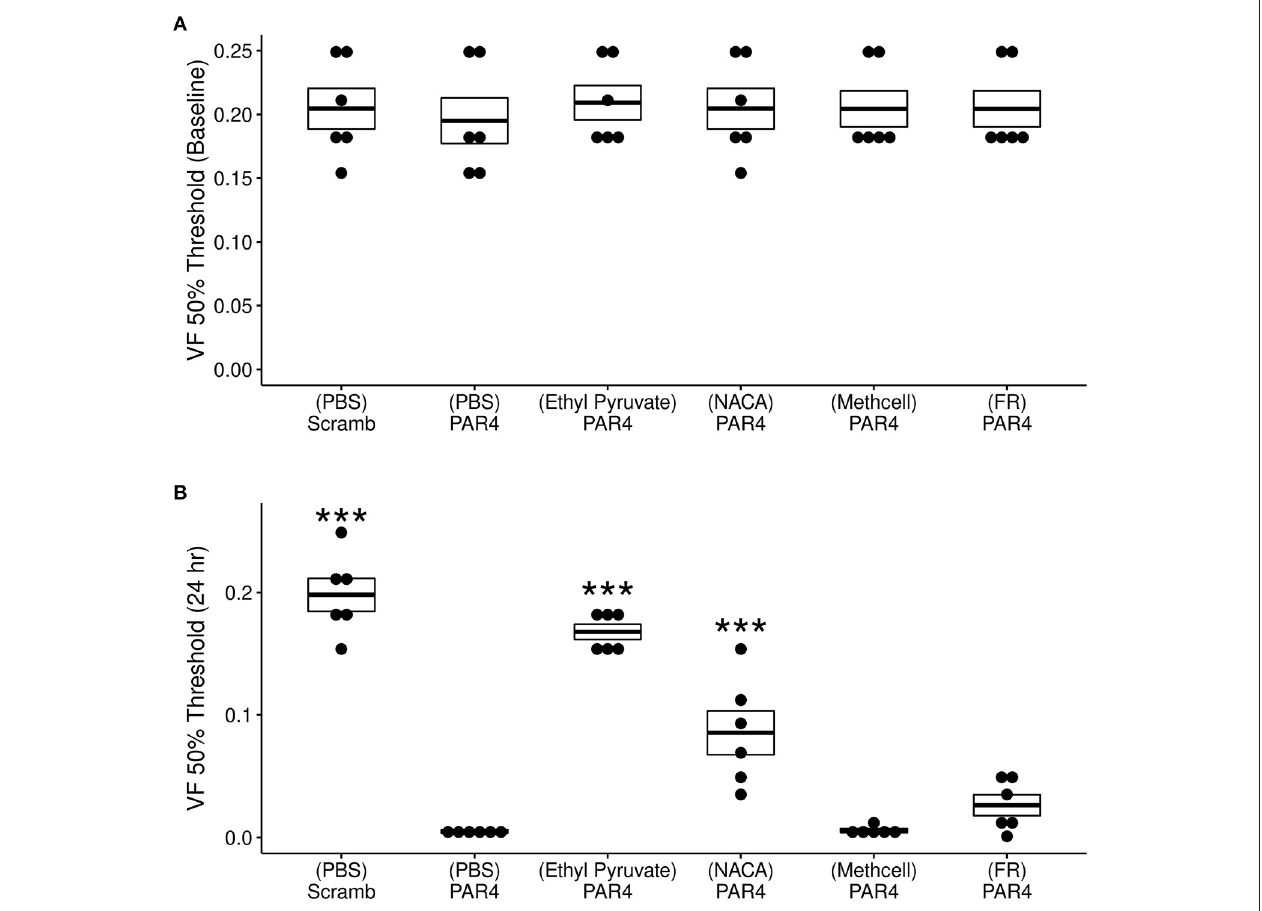
FIGURE 2 | Effects of different treatments ( N = 6/group) on protease activated receptor-4 (PAR4)-induced bladder hyperalgesia (BHA). (A) No difference in 50% von Frey (VF) threshold score from lower abdominal mechanical stimulation using VF monofilaments was observed at baseline across all treatment groups ( F = 0. 092; ns). (B) Significant differences were observed in VF threshold 24 h after treatment F = 69.71, p = 1.34 − 15 . Mice in the (PBS)-PAR4 (pain group) showed a profound decrease in VF threshold score when compared to the (PBS)- Scrambled group (No pain group). Pre-treatment with ethyl pyruvate nearly blocked while pre-treatment with N-acetylcysteine amide (NACA) partially blocked PAR4-induced decrease in VF 50% threshold. Pre-treatment with either methyl cellulose (Methcell) or FR180204 (FR) was not effective in blocking PAR4-induced BHA. *** p < 0.001; ns, not significant at p < 0.05.